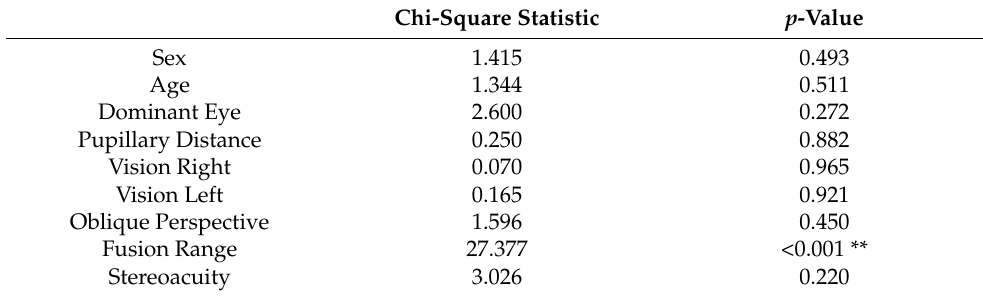
Table 5. Results of univariate logistic regression analysis of 377 visual examination results.